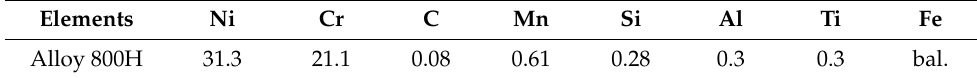
Table 1. The chemical composition (wt.%) of the base metal alloy 800H.